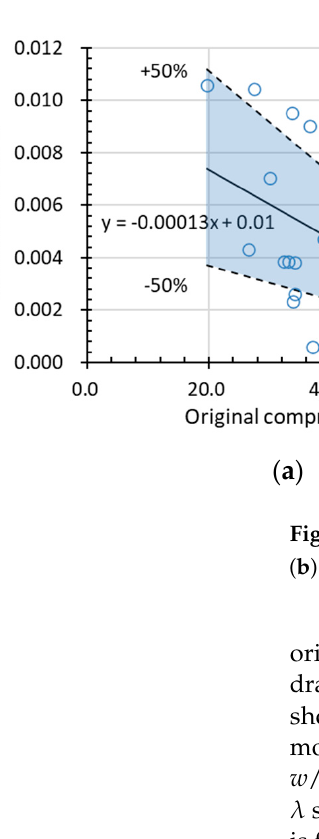
Figure 15. Factor α in the linear function in terms of w/c for ( a ) RDEM and ( b ) Rf c of non-air-entrained concrete.